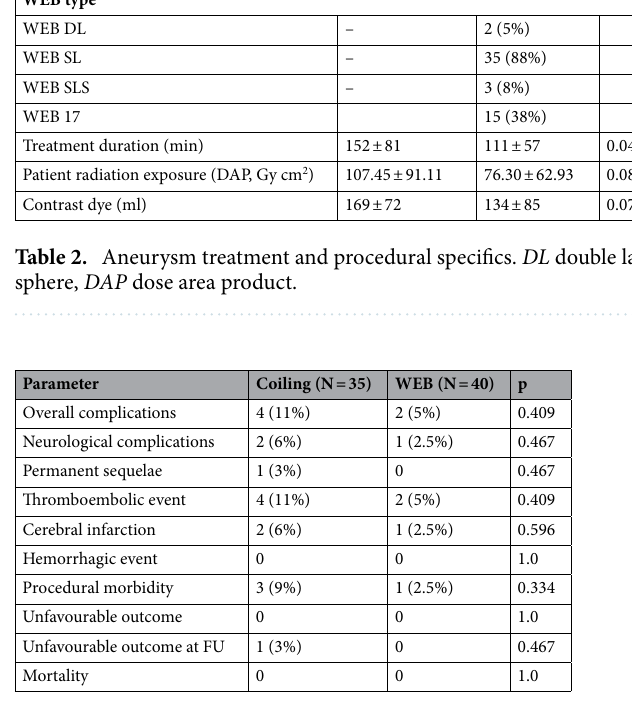
Table 3. Complications. FU follow-up.